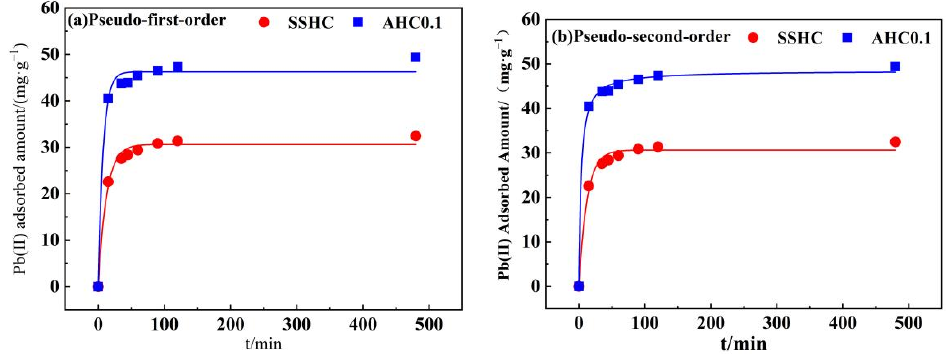
Table 5. Adsorption kinetics parameters of Pb( Ⅱ ) onto SSHC and AHC0.1.